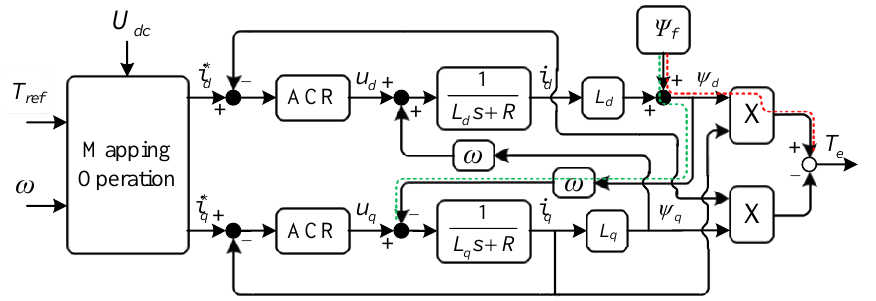
Figure 5. Flux variation of experimental prototype with d-q axis current: ( a ) d-axis flux surface; ( b ) q-axis flux surface.